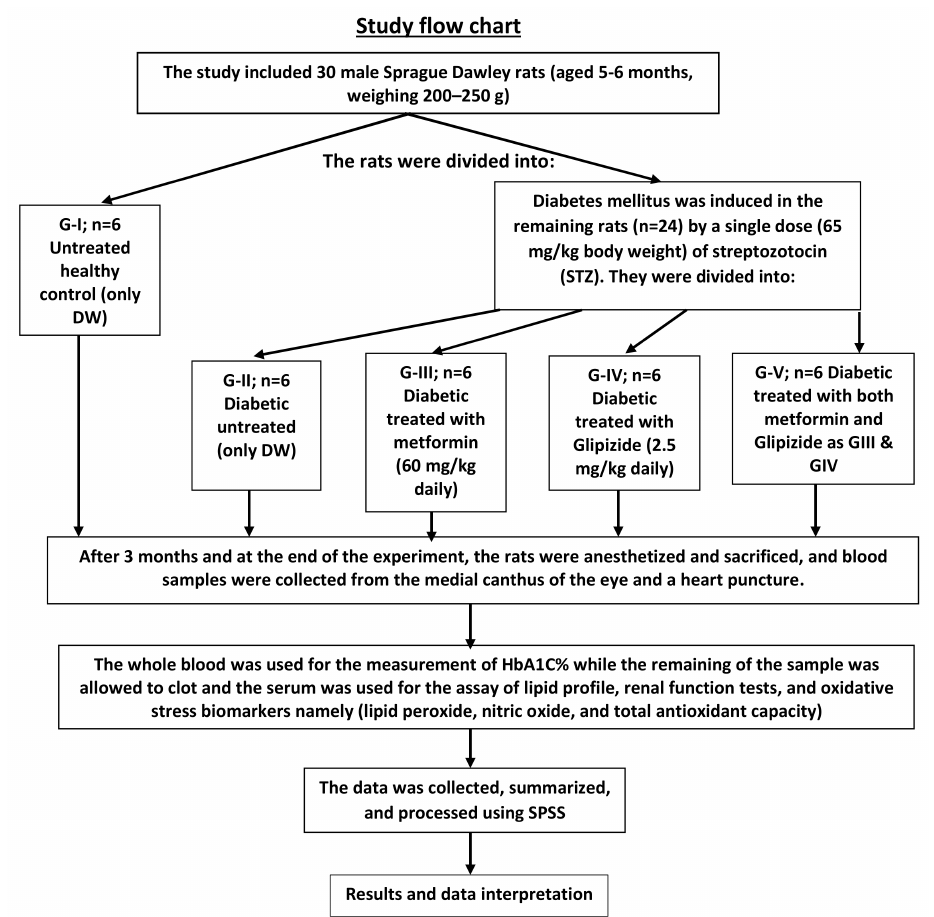
Figure 7. Scheme summarizes all the experimental groups, treatment and